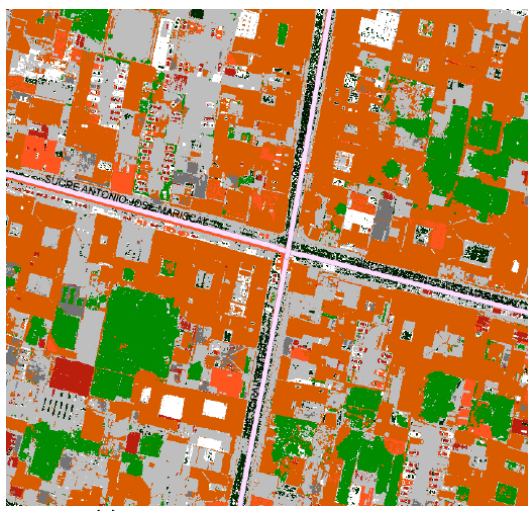
Figure 4. (b) 2016 raster image, 2,5cm/px. This image was classified and generalized with the SVM lineal function.